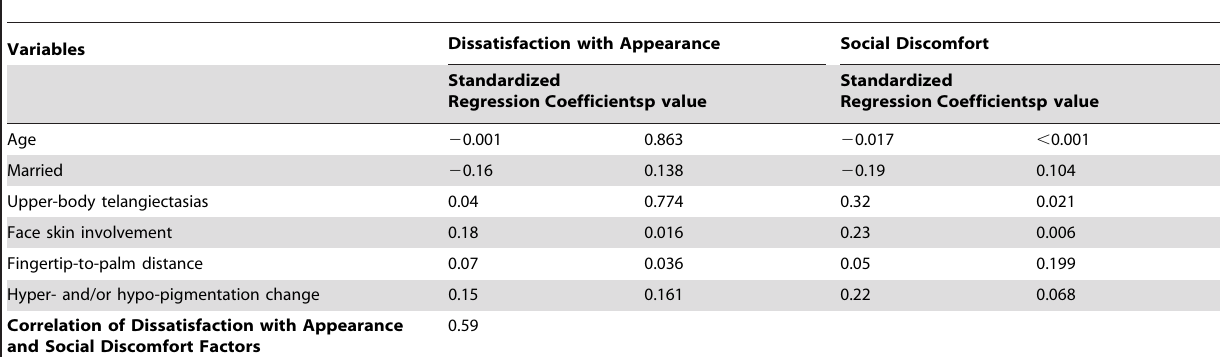
Table 3. Brief-SWAP Structural Equation Model of Relationships with Sociodemographic and Disease